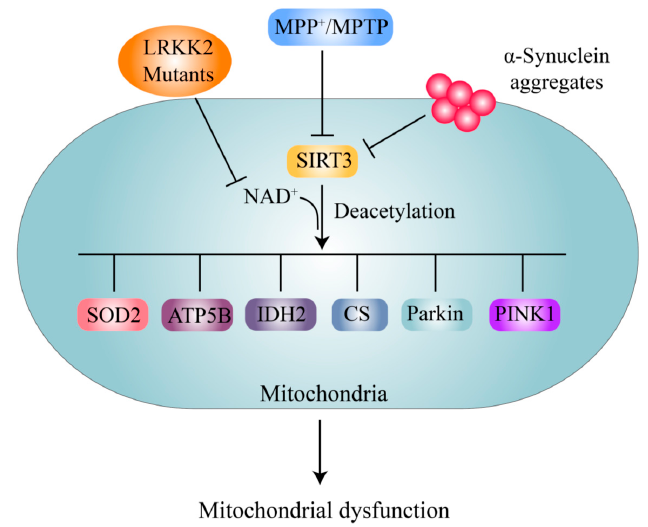
Figure 5. Acetylation of mitochondrial proteins by PD-related neurotoxins or genetic factors. α